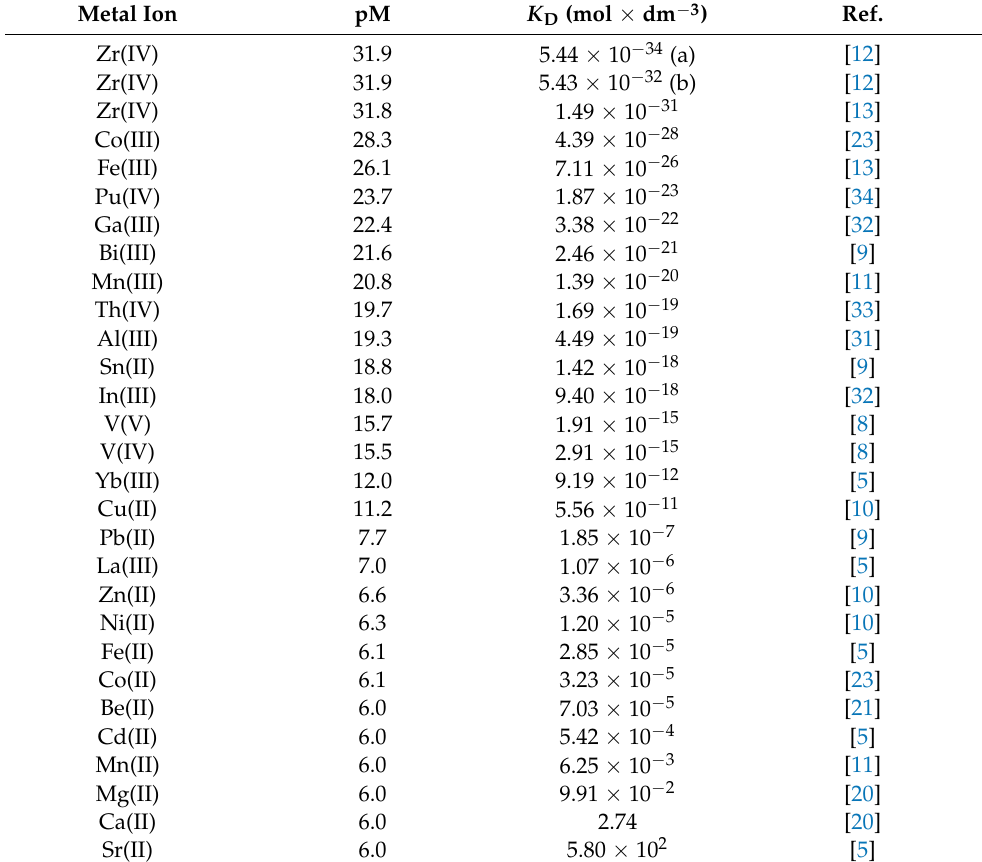
Table 8. Calculated pM and K D values for DFOB metal